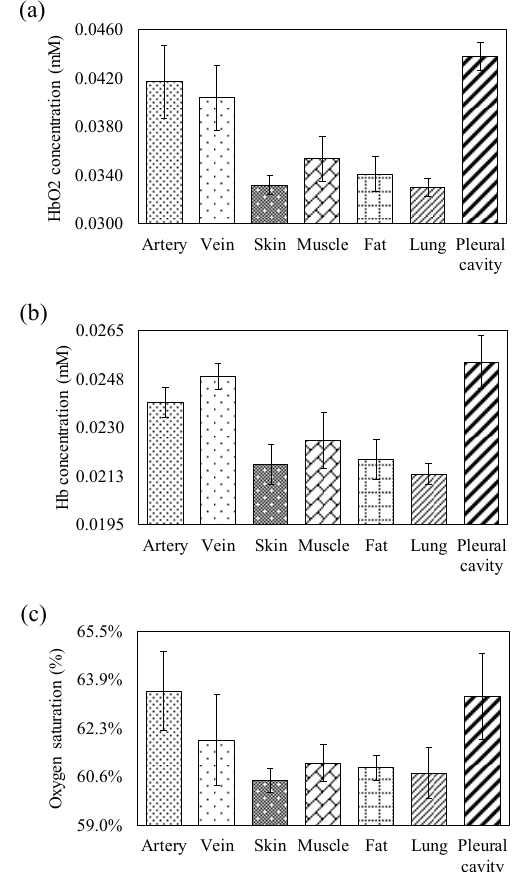
Figure 5. ( a ) Average HbO 2 concentrations, ( b ) Hb concentrations, and ( c ) StO 2 of di ff erent tissues in the in vivo experiment.